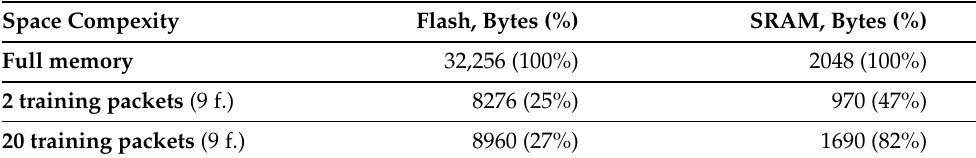
Table 2. Space complexity of the ANN model training on Arduino Uno Rev3.